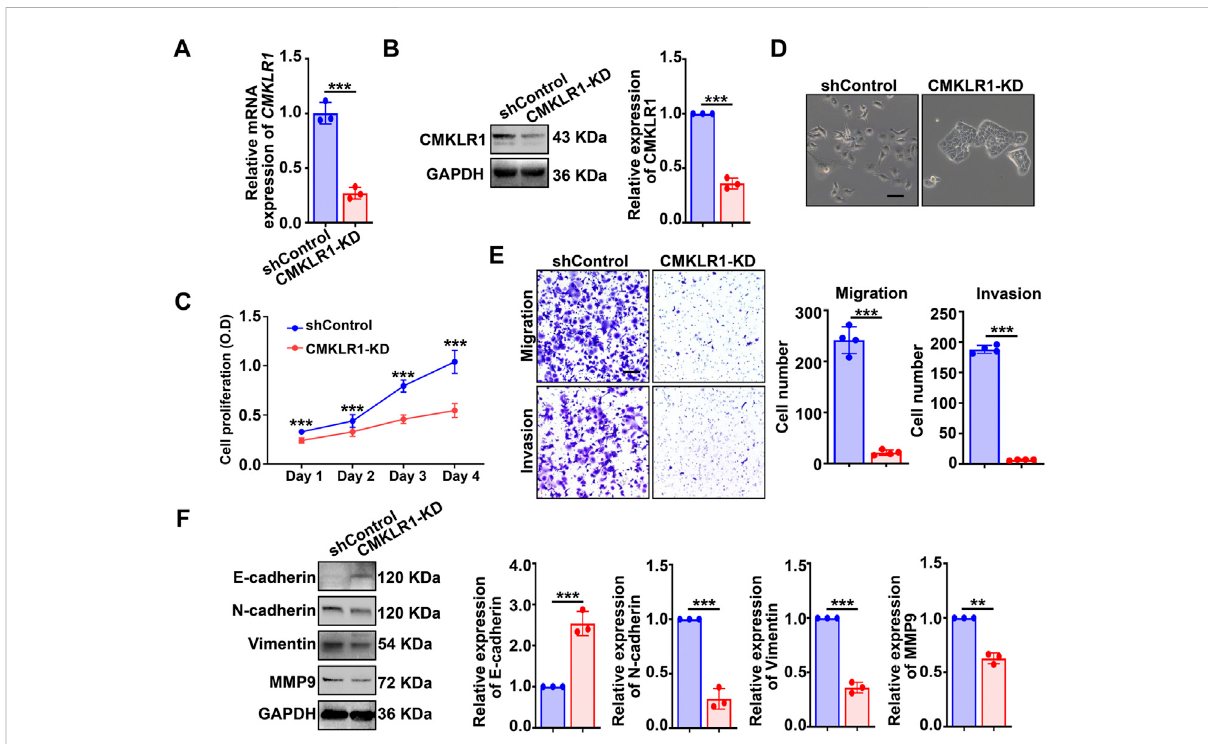
FIGURE 3 KnockdownofCMKLR1impairstheviability andmesenchymalfeaturesofhEM15A cells. (A,B) CMKLR1mRNAandproteinlevelsinhEM15Acells stably expressed scrambled shRNA (shControl) and shRNA targeting CMKLR1 (CMKLR1-KD) were measured by qPCR and western blot. (C) CCK-8 assay was used to access the cell viability. (D) Representative images of cellular morphology. Scale Bars, 50 μ m. (E) Transwell assay was utilized to evaluate cell migration and invasion ability, and the quantitative data was shown in the diagrams. (F) E-cadherin, N-cadherin, vimentin, and MMP-9 expression wasdetected byimmunoblots. Assays wereperformed intriplicate andthedensitometryofblots was shown. GAPDH servedas